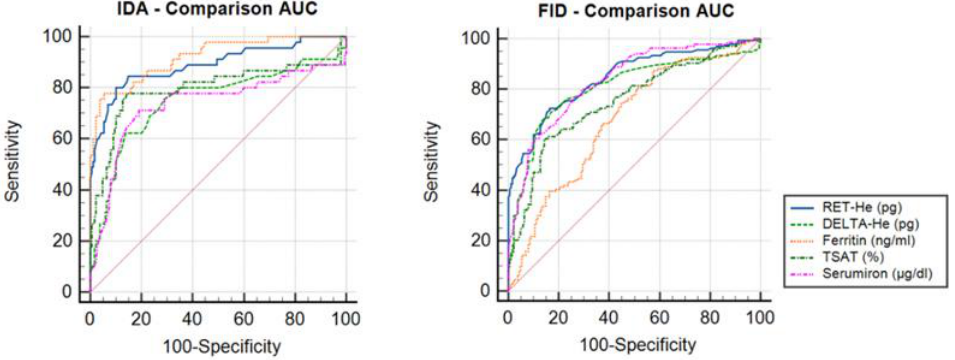
Figure 2. Comparison of the AUC in the IDA group and FID group. Table 4. Data of the area under the curve (AUC) comparison for the IDA and FID group. AUC (IDA): AUC